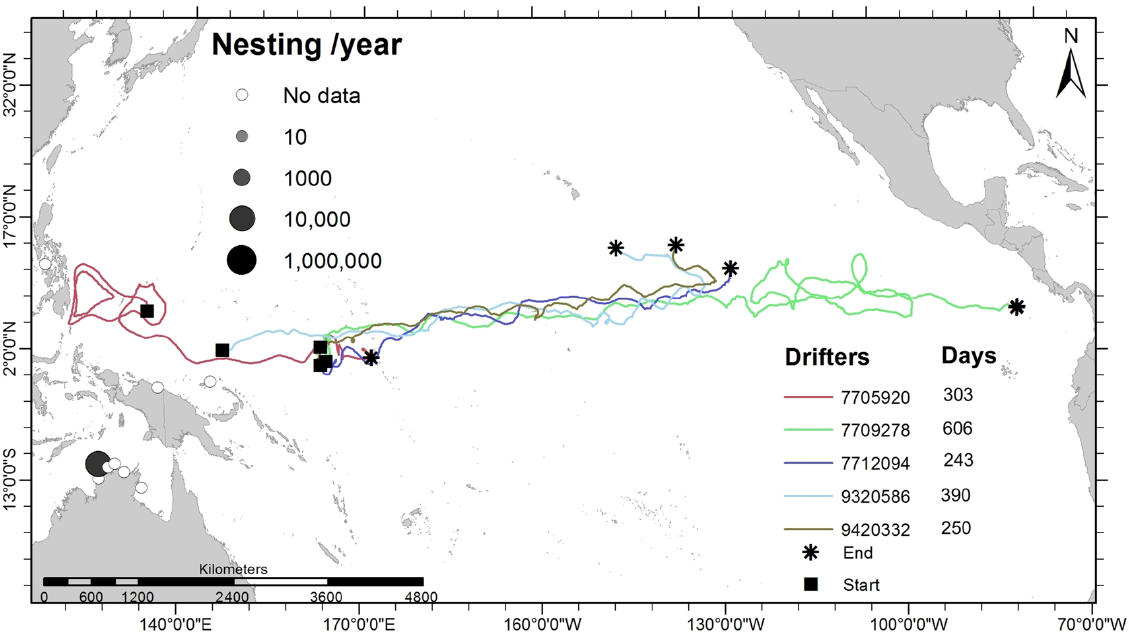
Figure 3. Satellite-tracked drifter buoy trajectories demonstrating potential ocean current pathways linking olive ridley turtle breeding areas in the Western Pacific with the Central Pacific and Eastern Pacific. Olive ridley rookery locations and abundances derived from [6] olive ridley IUCN Database. Drifter data from NOAA/AOML Global Lagrangian Drifter Data (http://www.aoml.noaa.gov/envids/gld/krig/parttrk_id_temporal.php (accessed on 7 December 2022)).